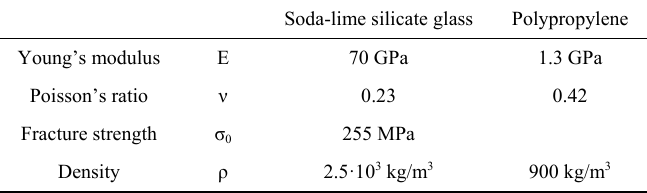
Table 4: Material properties for drop weight impact